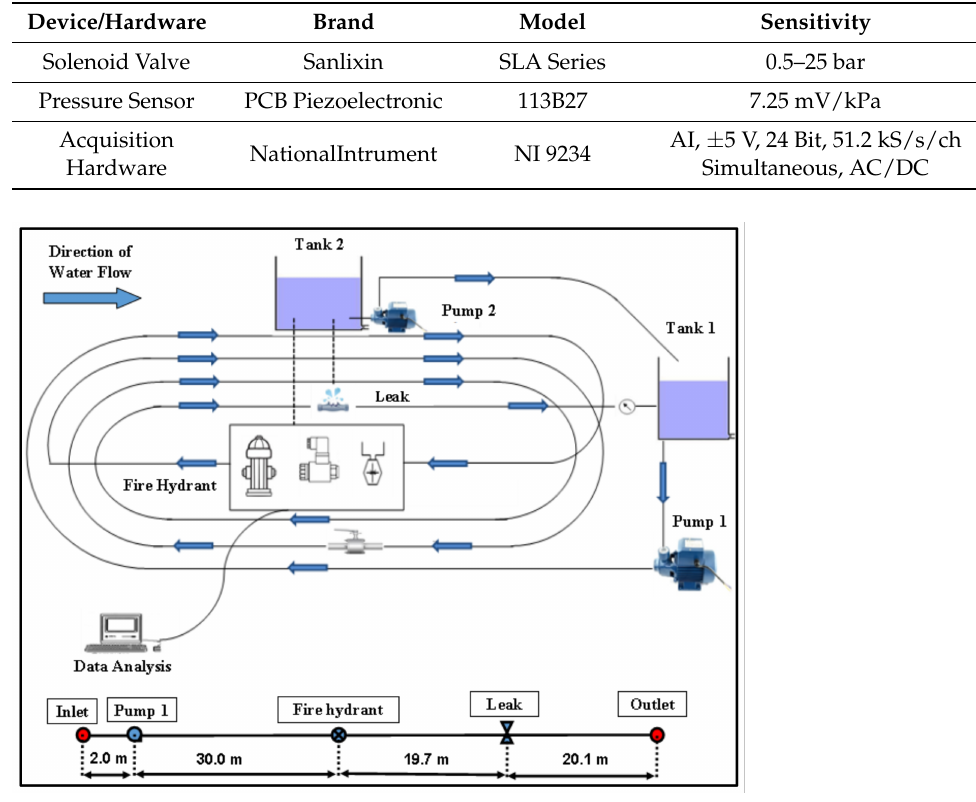
Figure 3. Test rig schematic diagram.